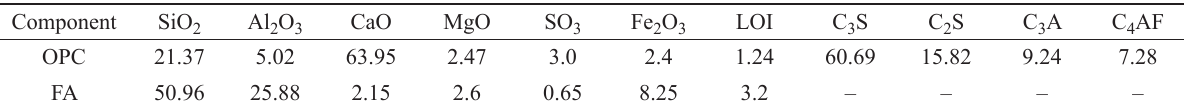
Table 1. Chemical composition of the OPC and the FA [mass %] Component